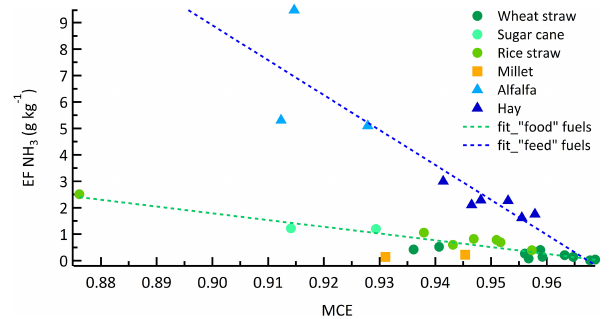
Figure 11. Emission factors of NH 3 as a function of MCE for “feed” crop residue fuels (triangles), “food” crop residue fuels (cir- cles), and older millet samples (squares). Also shown are the lines of best fit from food fuels (green) and feed fuels